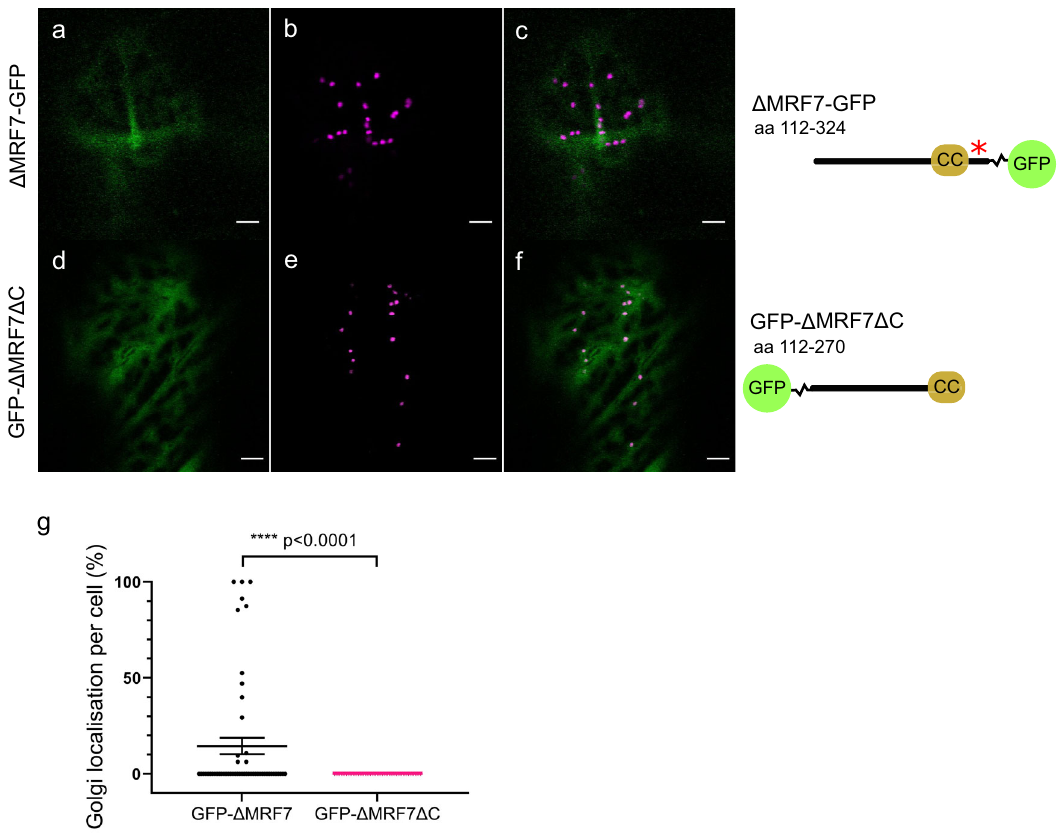
Fig. 3 MRF7 C-terminal region affects Golgi localisation. a – c C-terminal fusion of GFP to Δ MRF7 localises to the cytosol, suggesting that the Golgi- targeting information could reside at the C-terminus of MRF7 (red asterisk). The C-terminal GFP fusion could be responsible for masking such signal, preventing a Golgi localisation. d – f Localisation of GFP- Δ MRF7 Δ C re fl ects that of Δ MRF7-GFP, indicating that the last 54 amino acids are fundamental to target MRF7 to the Golgi. g Quanti fi cation of GFP- Δ MRF7 Δ C Golgi localisation compared to that of GFP- Δ MRF7. Each datapoint represents one cell; values on the left-hand side indicate the percentage of Golgi in a particular cell with GFP- Δ MRF7 or GFP- Δ MRF7 Δ C surface localisation. Data from 53 cells (GFP- Δ MRF7) and 51 cells (GFP- Δ MRF7 Δ C) from 5 independent experiments, Mann – Whitney test, **** P < 0.0001. All imaging carried out two days post- in fi ltration. Scale bar = 5 μ